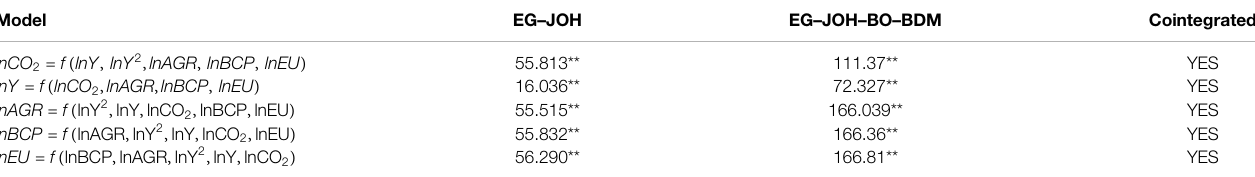
TABLE 5 | Estimates of cointegration test via Bayer-Hanck.